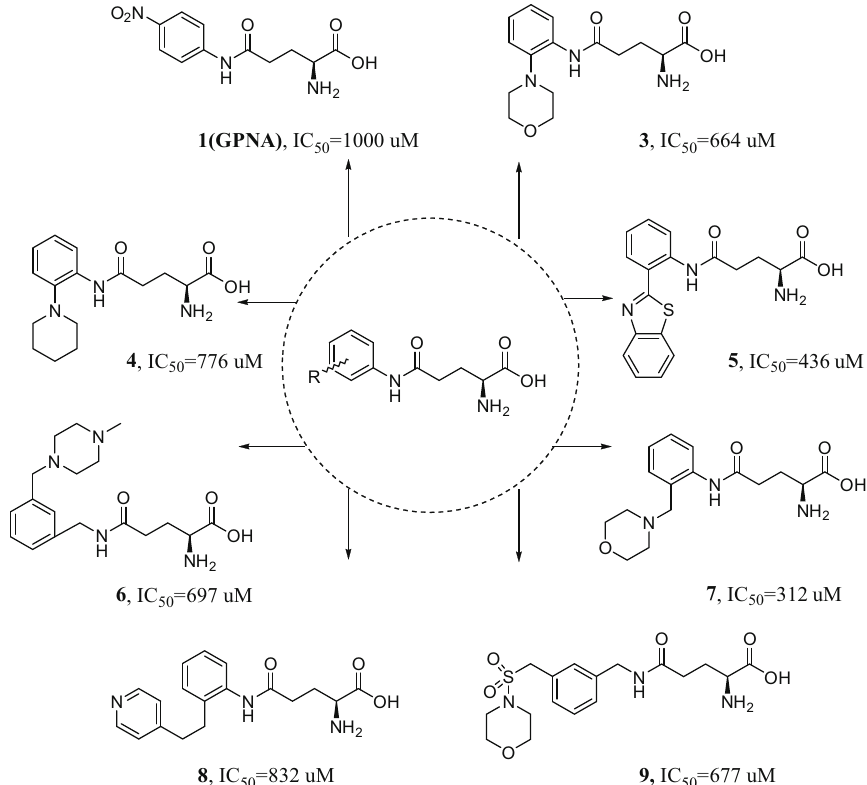
Figure 5: Structures of compounds 1, 3 – 9